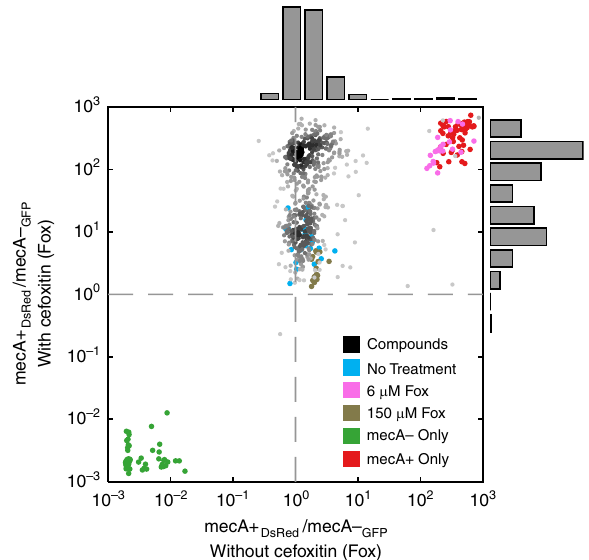
Fig. 3 Selection for mecA by diverse chemical compounds is potentiated by cefoxitin. Addition of subinhibitory level of cefoxitin to the medium biases selection for the mecA + strain by many compounds (density plot, bimodal distribution of the ratio of normalized fl uorescence of mecA + to mecA − cells; compounds from distribution peaking at ~10 are similar to no- drug control and are de fi ned as non-selecting compounds, compounds from distribution peaking at ~100 are de fi ned as compounds selecting for the mecA + strain). No differential selection by most compounds of competing mecA + and mecA − cells in the absence of subinhibitory cefoxitin in the medium (ratio of normalized fl uorescence of mecA + to mecA − cells is ~1). Source data are provided as a Source Data fi